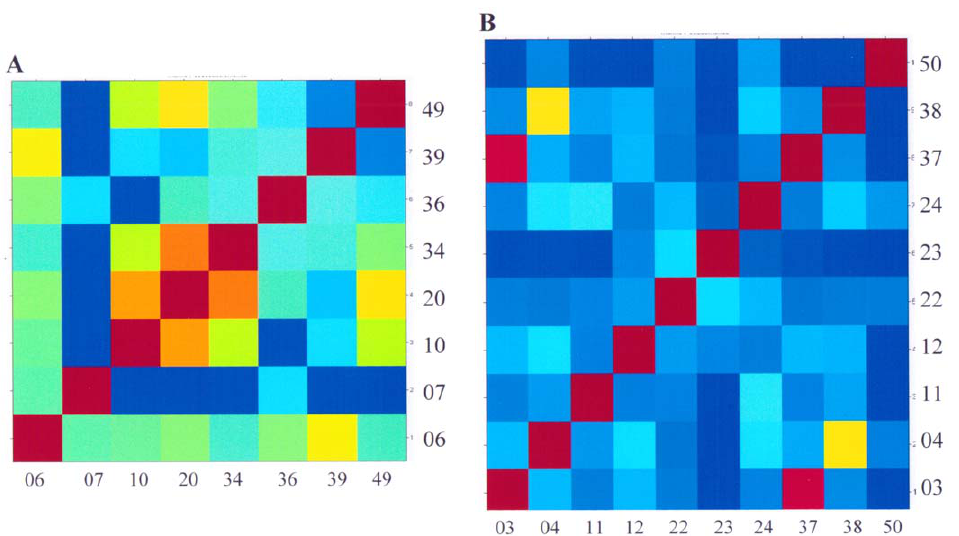
Figure 7. Heat-map of Pseudoalteromonas (A) and Pseudomonas (B) isolates generated by the Biotyper software. The spectra were split into 8 or 11 groups according to the directory structure. Red colours indicate closely related groups with identical peaks, and blue colours mark non- related groups.